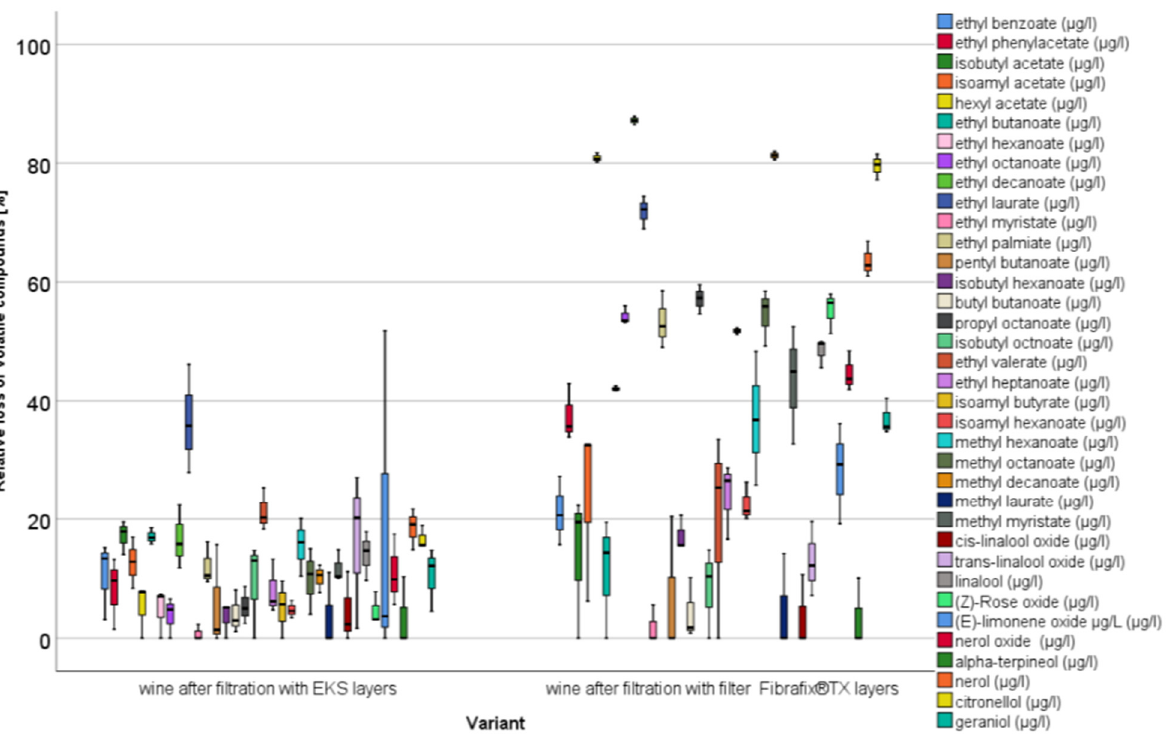
Figure 7. Reduction in volatile compounds. Comparison of end products after 1250 L filtration capacity per m 2 filter area. Significance test in Supplementary Material Table S7.